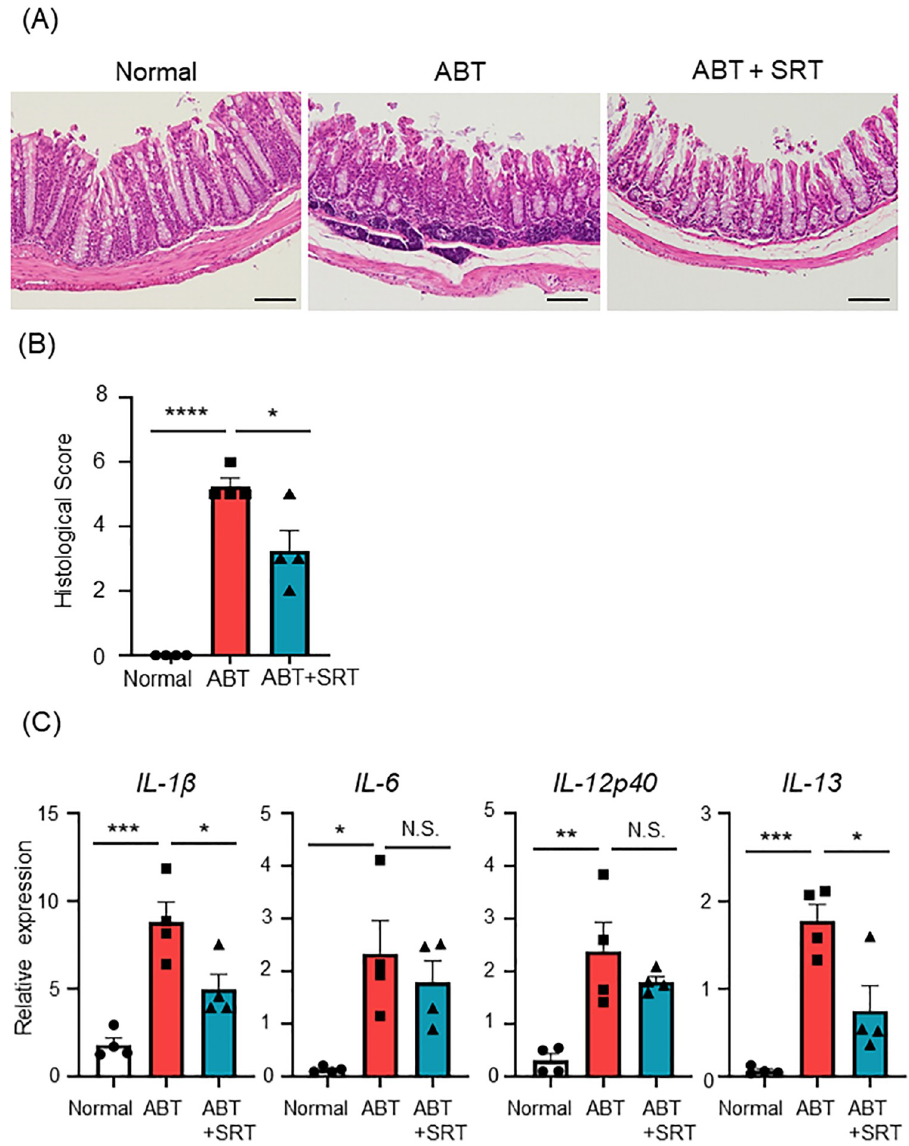
Fig 2. Effect of Saireito on antibiotics-induced colon inflammation. Mice in normal group were given a normal diet and normal drinking water; ABT group mice were given a normal diet and A + V solution in drinking water for the last 7 days; ABT + SRT group mice were fed a 1.5% Saireito diet until the last day and given A + V solution in drinking water for the last 7 days. (A) The colon was excised on day 28, sectioned, and stained with H&E ( × 200). (B) Graph shows the histological score. (C) mRNA expression level of pro-inflammatory cytokines was determined by quantitative RT-PCR. Statistical analysis was carried out using one-way ANOVA followed by Tukey’s multiple comparisons test. Results are expressed as the mean ± SEM (n = 4, each group). � P < 0.05, �� P < 0.01, ��� P < 0.0001, ���� P < 0.0001, and NS: not